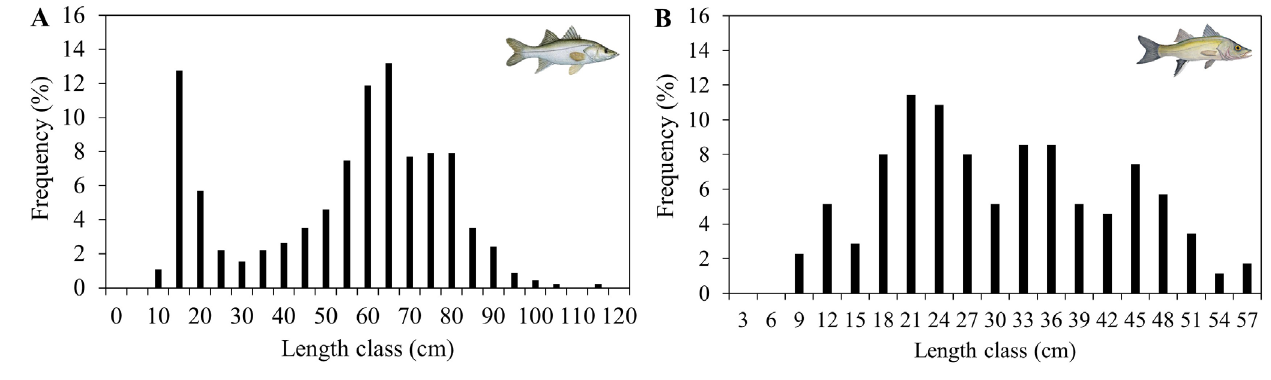
FIGURE 2 | Frequency distribution of Centropomus undecimalis ( A ) and Centropomus parallelus ( B ) collected in the state of Alagoas, Brazil.